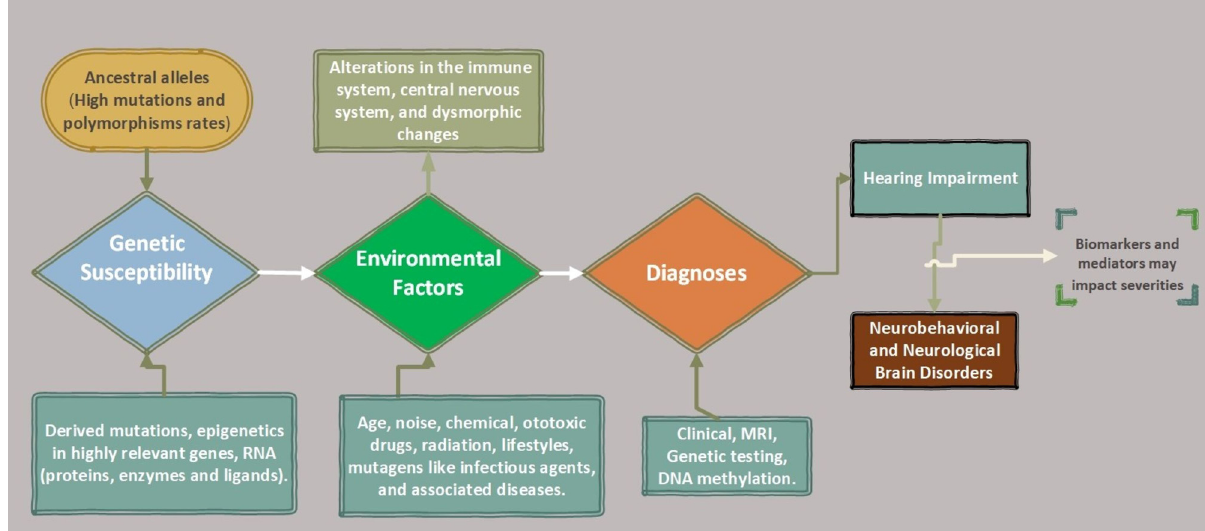
Figure 2: The description of intrinsic, extrinsic factors and disease modi fi ers underlying the pathologies of HL co - interactions with brain